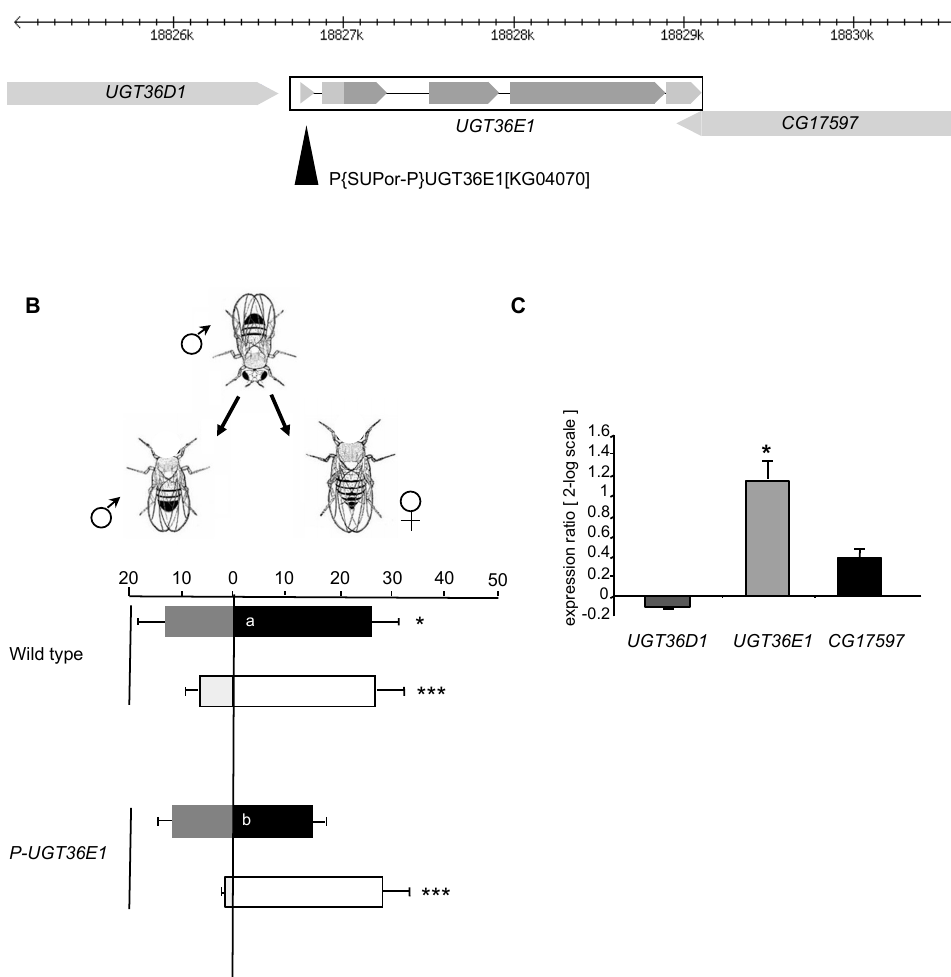
Figure 1. Effects of the P-element insertion in UGT36E1. ( A ) Schematic organization of the 37B1 chromosomal region. Arrowhead indicates the position of the P-element inserted in the 5’UTR region of UGT36E1. ( B ) The P-element inserted in UGT36E1 (P-UGT36E1) affects sex pheromone discrimination in male flies. Tests were carried out either under red light (filled bars) or white light (empty bars). Each mirrored bar represents the mean (± s.e.m.) courtship index towards female (CIf) and male (CIm). Individual 4-day-old tester males directed towards female (right) and male (left) headless targets, simultaneously presented during a 5 min observation period. Tester males were homozygous (P-UGT36E1) for the P-element mutation, or wild-type (Dijon strain); target flies always belonged to this wild-type strain. Significant differences for male ability to discriminate between the two sexes are shown next to each mirrored bar as ***: p < 0.001; **: p < 0.01; *: p < 0.05 (Student’s t -test). Courtship data towards each sex were tested using ANOVA and LSD Fisher tests (letters within bars indicates significant differences towards each sex). For each test, the number (n) was n > 40 (under red light) and n > 30 (under white light). ( C ) The P-element insertion affects RNA expression levels of